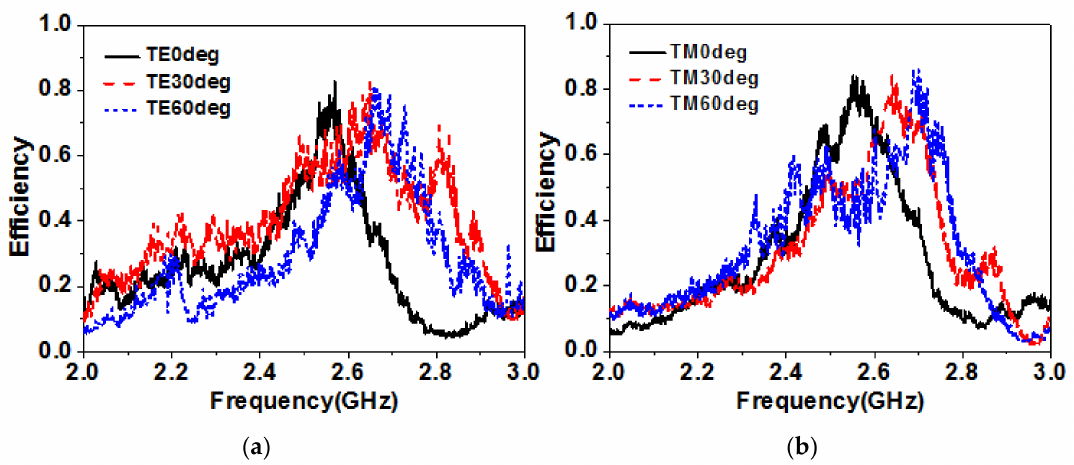
Figure 11. Measured energy harvesting efficiency of the fabricated 9 × 9 MS energy harvesting array for different polarization and incident angles, ( a ) TE-polarized oblique incidence and ( b ) TM-polarized oblique